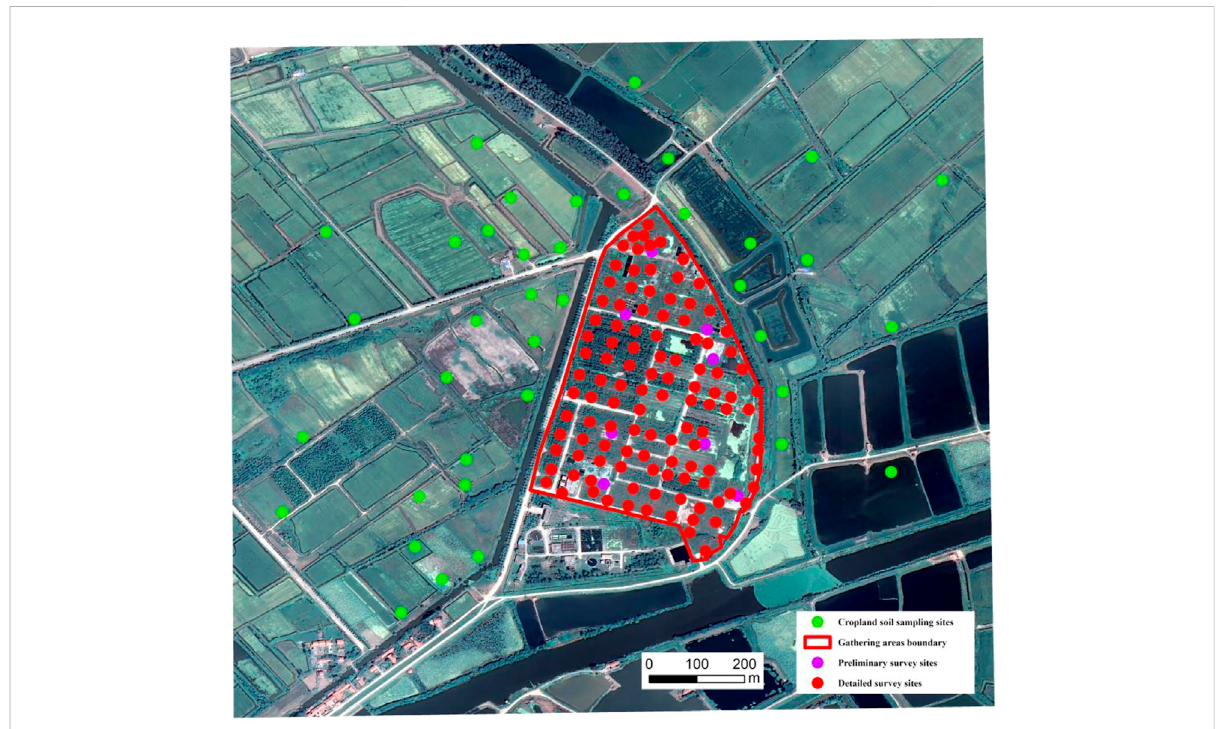
FIGURE 1 Distribution of sampling points within pharmaceutical complex and surrounding agricultural soil.